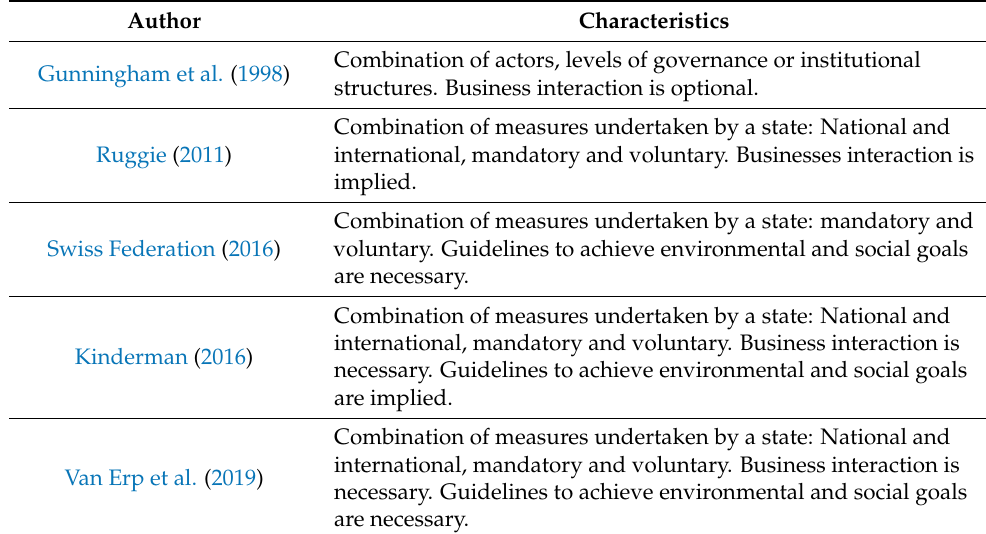
Table 1. Evolution of the definition of Smart